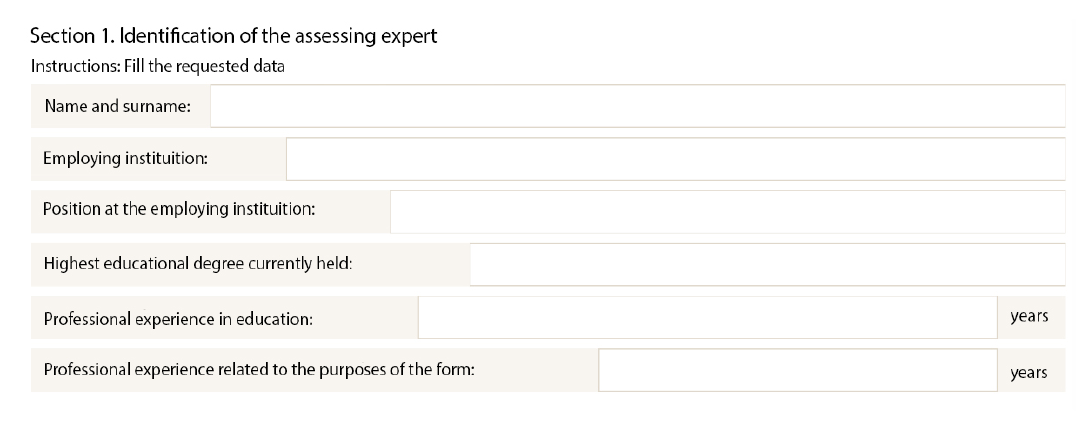
Figure 1. A screenshot of the online validation form (section